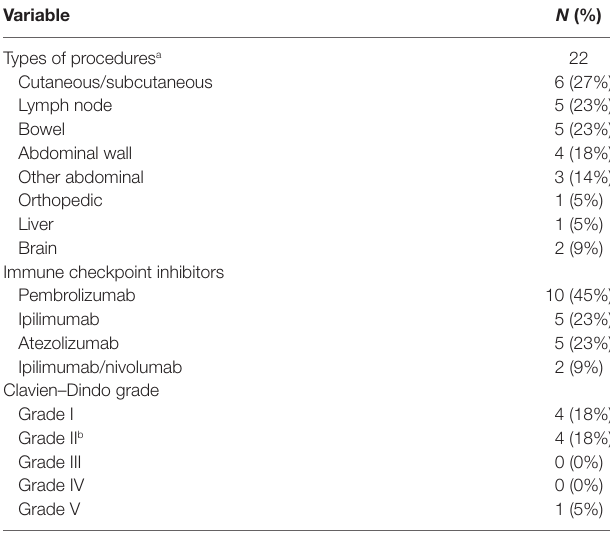
a One procedure may fall into multiple categories. b Total of five grade II complications during four